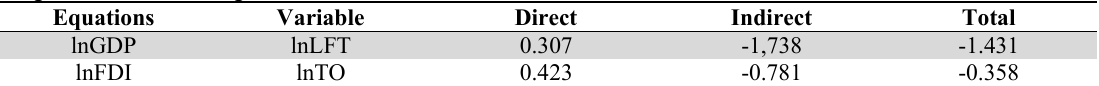
Exogenous variables marginal